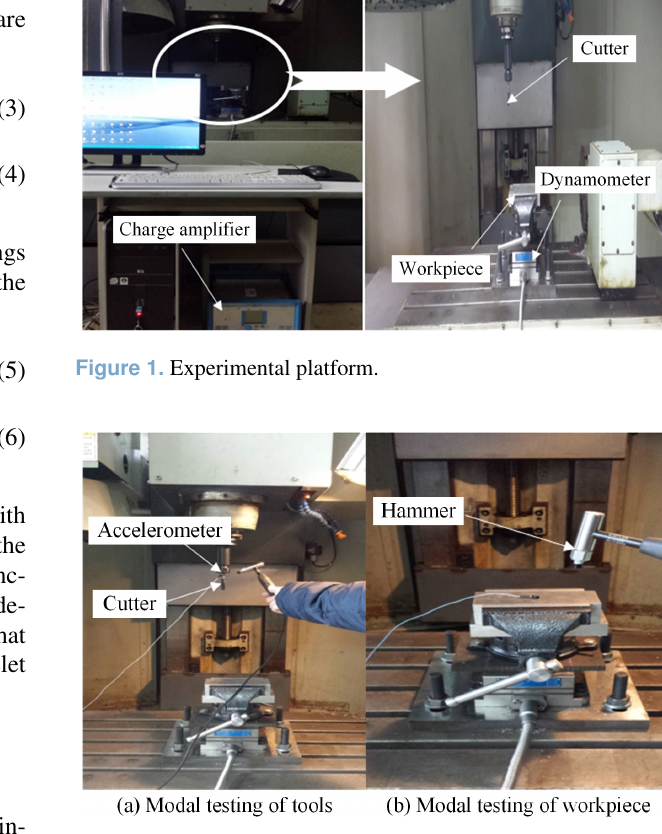
Figure 2. Measurement of dynamic